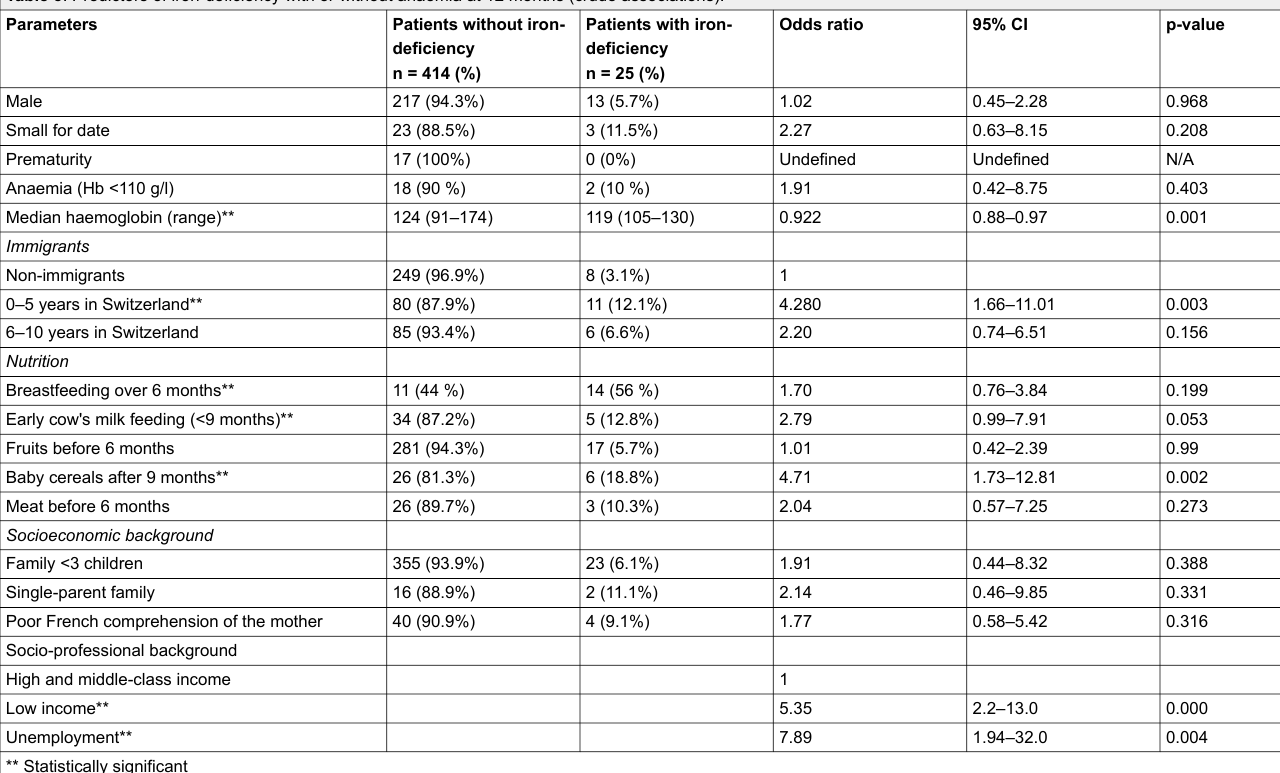
Table 3 : Predictors of iron-deficiency with or without anaemia at 12 months (crude associations).